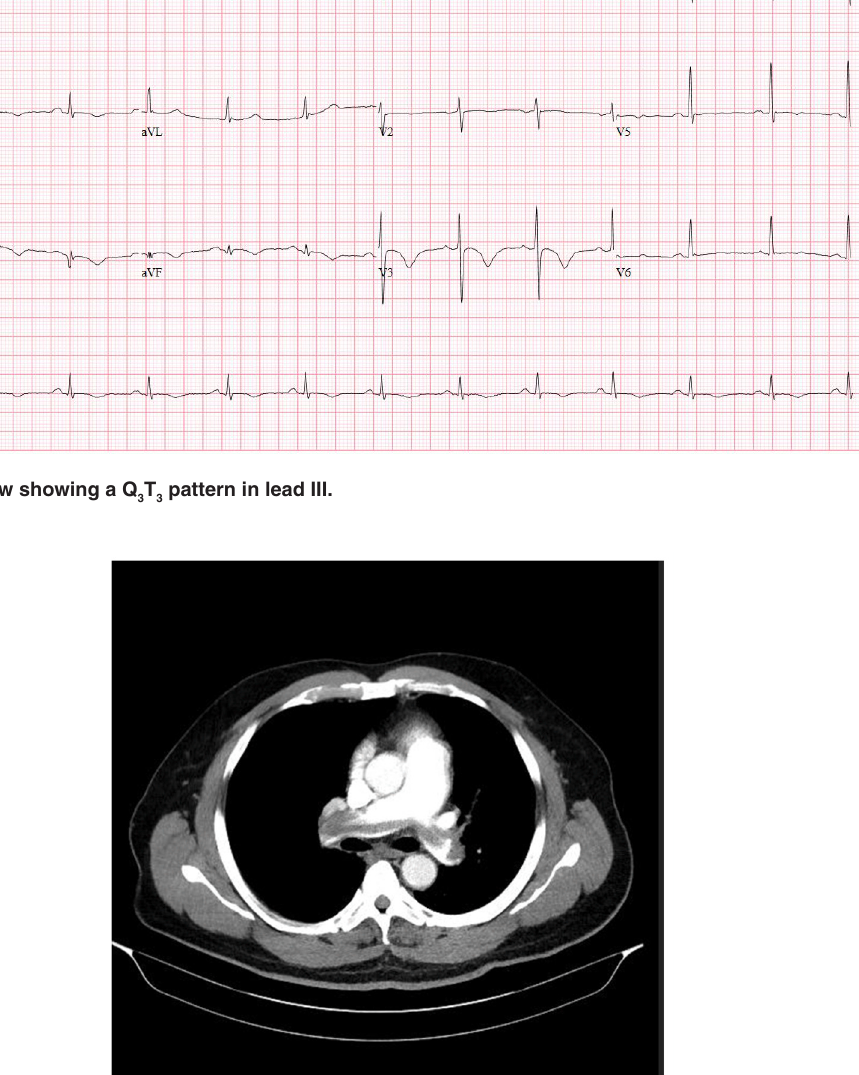
Figure 3. Axial CTA of the chest showing a saddle embolus with extension into the branches of the pulmonary artery. CTA was performed using Siemens SOMATOM Perspective 128 slices. Images were obtained in a cranio-caudal direction following contrast injection at 3mls/s. Contrast optimization was based on bolus tracking at the level of the main pulmonary artery using a trigger level of 100